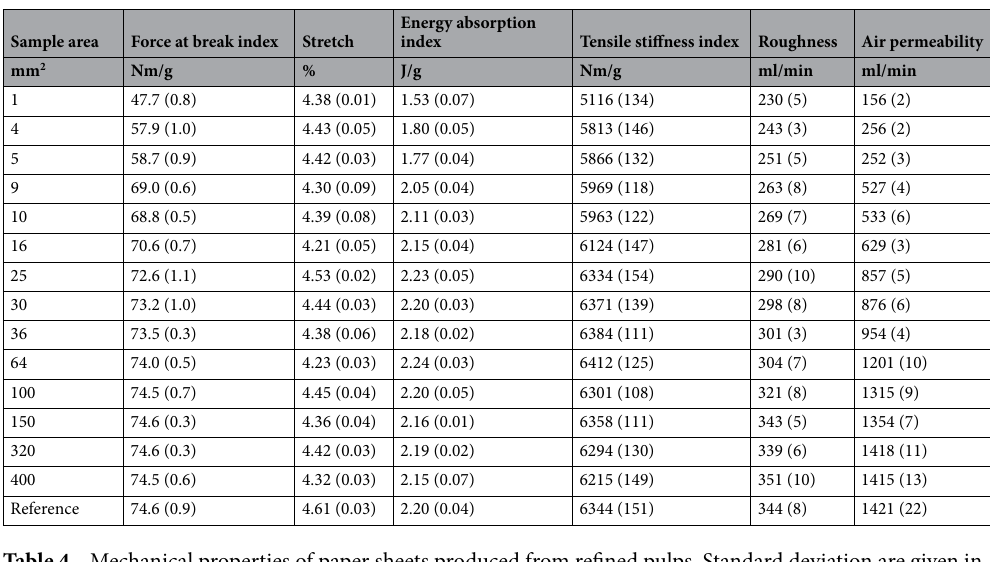
Table 4. Mechanical properties of paper sheets produced from refined pulps. Standard deviation are given in brackets.